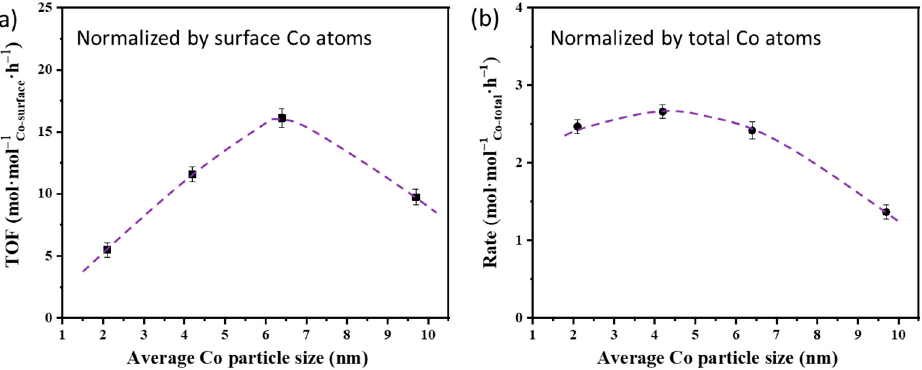
Figure 2. Effects of Co particle size on the rate of ethylene glycol conversion over Co/ γ -Al 2 O 3 catalysts normalized by ( a ) the surface Co atoms and ( b ) the total Co atoms (453 K, 0.13 mol/L ethylene glycol in tetrahydrofuran solution, 0.6 MPa NH 3 , 3.0 MPa H 2 , controlled at ~20% conversion). Dashed lines indicate trends.